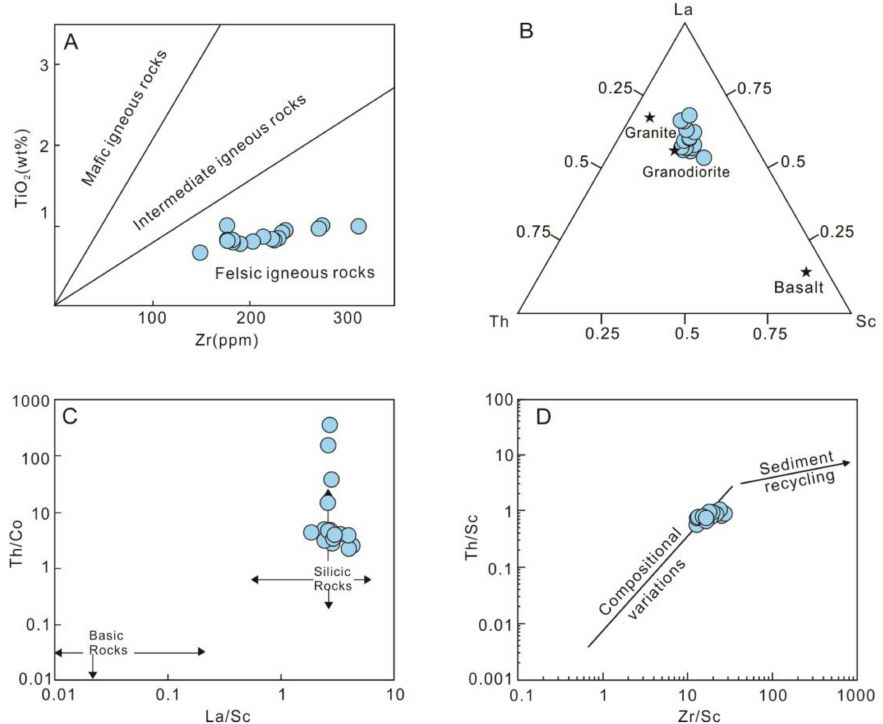
Figure 7. Discrimination diagrams illustrating sedimentary provenance and recycling effect. ( A ) TiO 2 vs. Zr [89]. Samples from Niutitang Formation suggest that the source rocks were predominantly felsic. ( B ) La-Th-Sc ternary diagram [90]. Samples from Niutitang Formation are plot close to granodiorite. ( C ) Th/Co vs. La/Sc diagram [91]. Samples from Niutitang Formation are consistent with a silicic rocks source. ( D ) Th/Sc vs. Zr/Sc diagram [88]. Samples from Niutitang Formation plot in the area with no sediment recycling